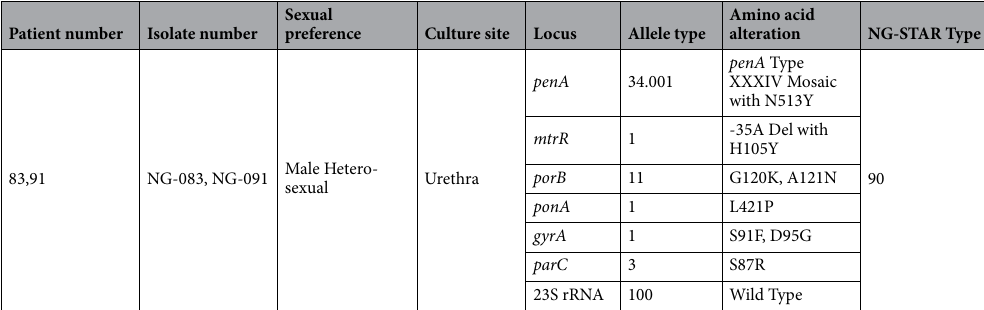
Table 4. Mutations in resistance determinants and NG-STAR sequence types of N. gonorrhoeae clinical isolates with reduced susceptibility to ceftriaxone (n = 2), Thailand, 2016–2018. MIC minimum inhibitory concentration, WT wild type, New new mosaic pattern, PBP2 penicillin binding protein 2, PBP1 penicillin binding protein 1, mtrR mtrR promoter, MtrR MtrR repressor, PorB PorB porin, NG-STAR Neisseria gonorrhoeae sequence typing for antimicrobial resistance ST, sequence type, A Del adenine deletion. * N. gonorrhoeae isolates with reduced susceptibility to